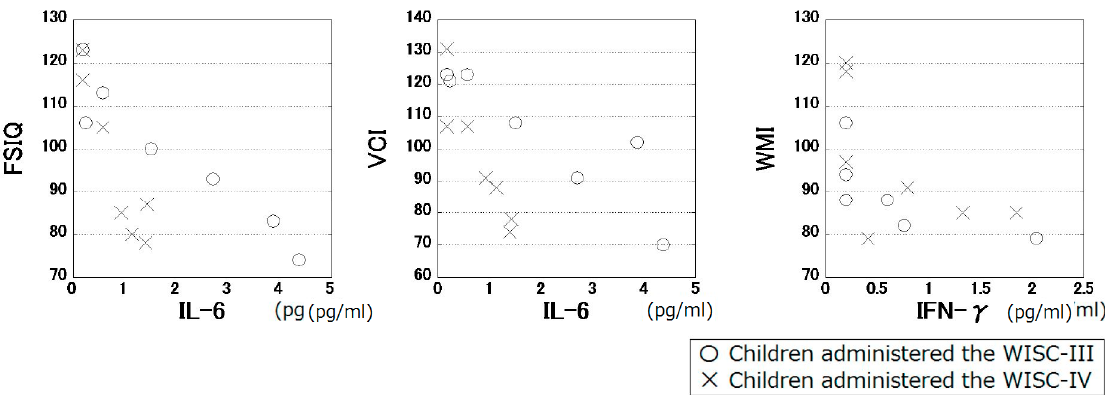
Figure 1. Significant correlations of serum IL-6 levels with FSIQ and VCI were observed in children administered the WISC-III as well as in those administered the WISC-IV.